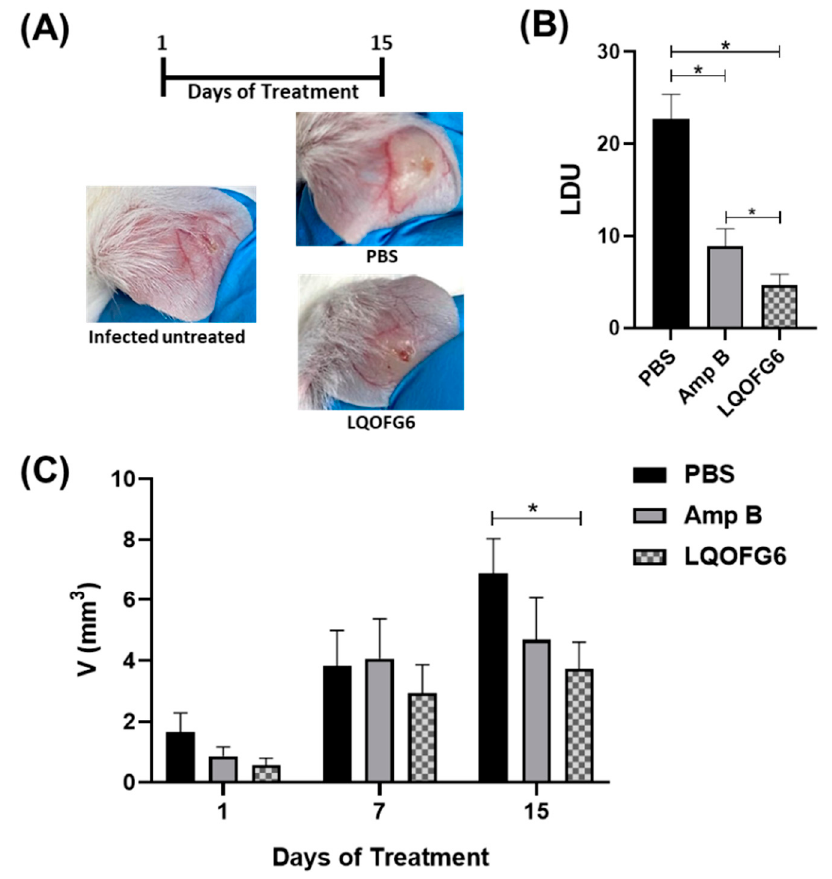
Figure 6. In vivo efficacy of LQOF-G6 and Amp B treatment in BALB/c mice infected with L. amazonensis . ( A ) Representative photographs showing the lesions in the ear of L. amazonensis -infected BALB/c mice nontreated or treated with LQOF-G6 or vehicle (PBS). The infected animals were treated with 2.0 mg/kg/day of LQOF-G6 or Amp B via IP. ( B ) Parasite load determination: at the end of treatment, the tissue parasite load was quantified using the LDU index (i.e., the number of Leishmania amastigotes in 1000 nucleated cells per organ weight). ( C ) Lesion progression during infection: The development of ear lesions was monitored for 15 days and the mean volume (volume (V) = D × d × e , where D is the larger diameter, d is the minor diameter, and e is the thickness) of lesions in each group was calculated. The control used was 1X PBS. Data are expressed as averages plus the SD. * Statistically significant difference between groups ( p < 0.01).